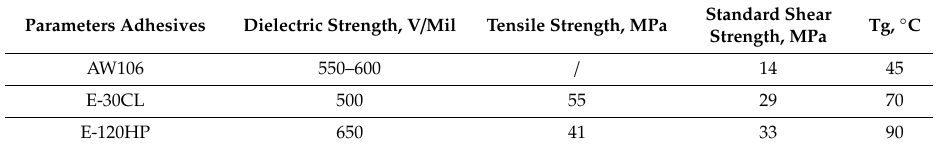
Table 3. Performance parameters of epoxy resin AB